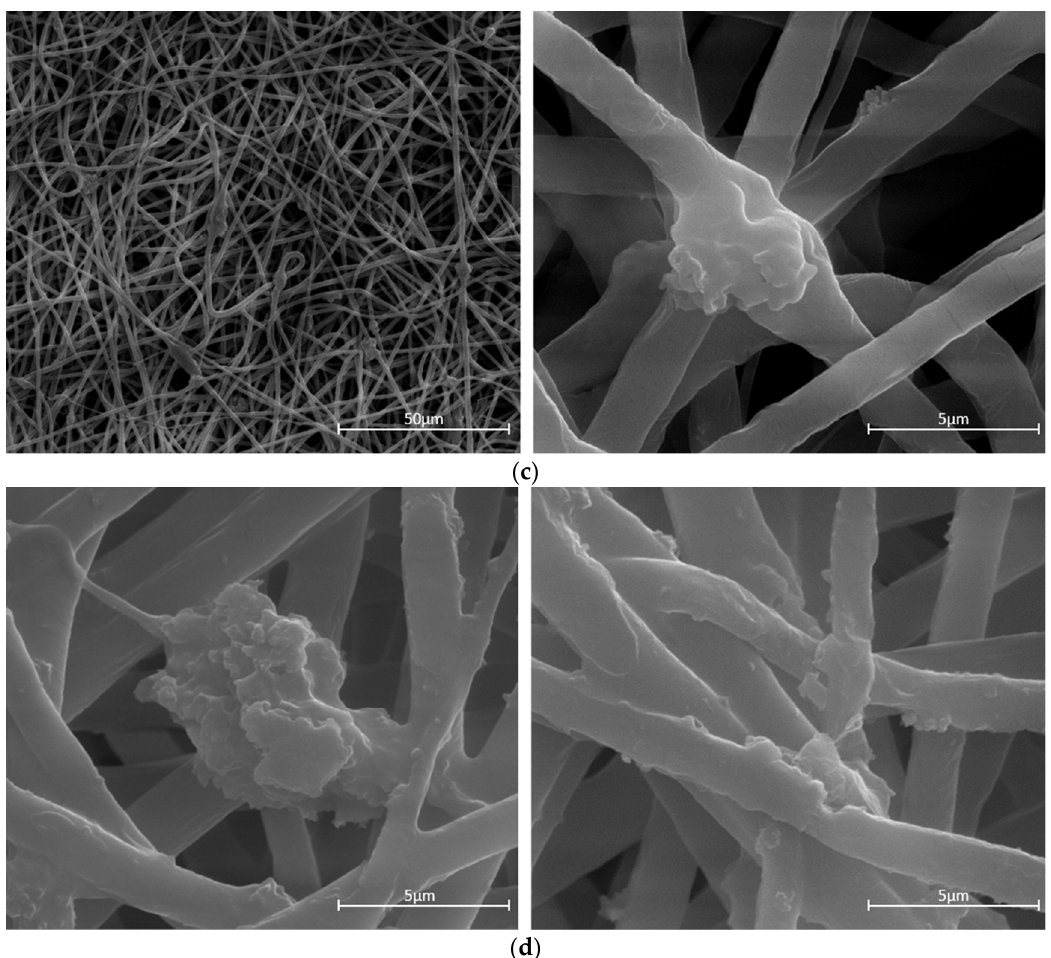
Figure 2. SEM images of ( a ) pristine PCL electrospun membranes, ( b ) modified PCL electrospun membranes, ( c ) PCL-g-C 3 N 4 /CQDs electrospun membranes, and ( d ) modified PCL-g-C 3 N 4 /CQDs electrospun membranes.